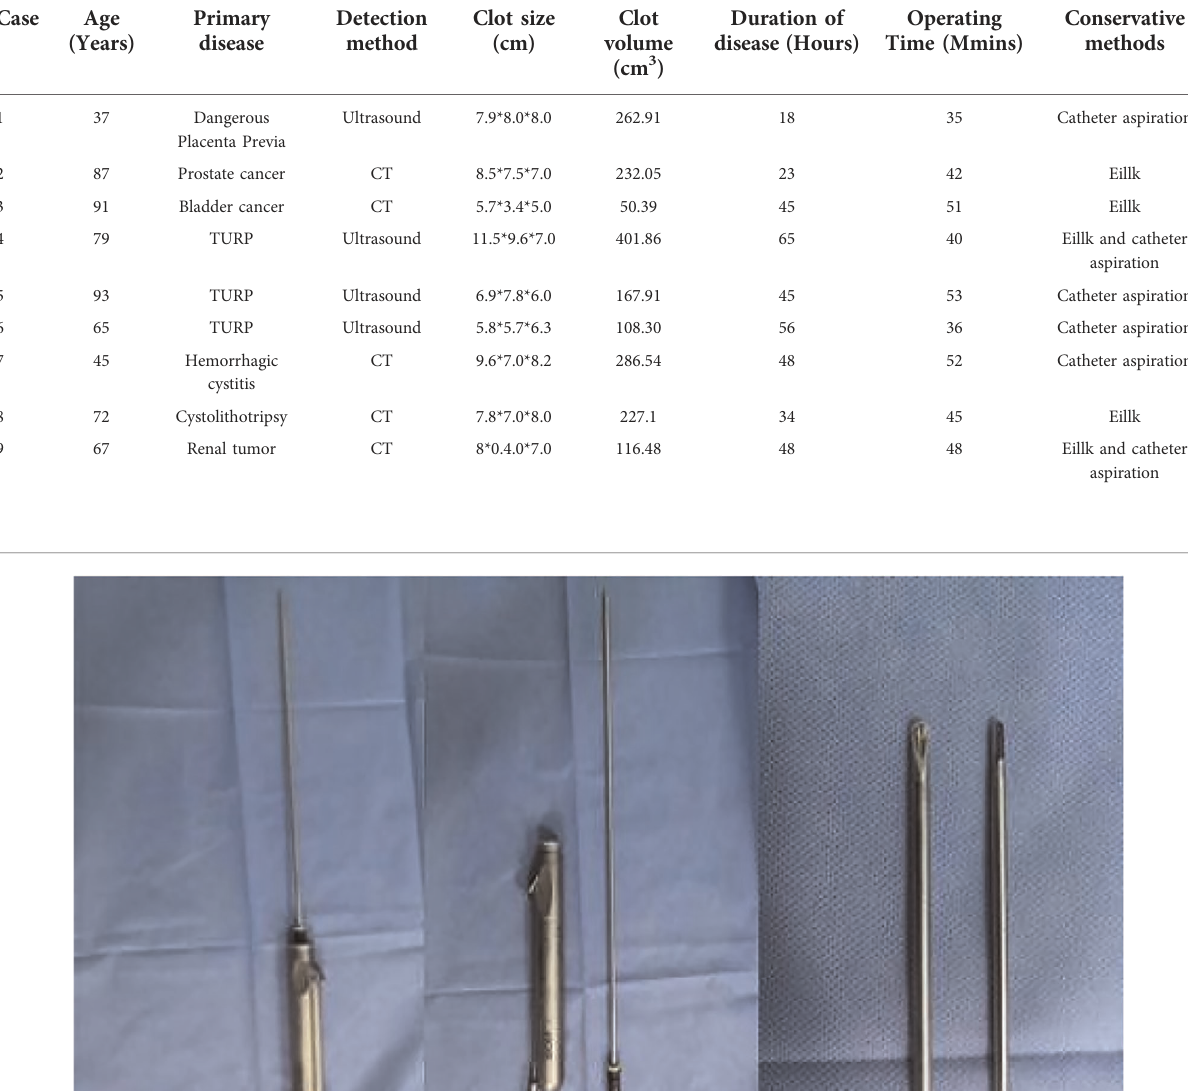
TABLE 1 The basic characteristics of the included subjects.